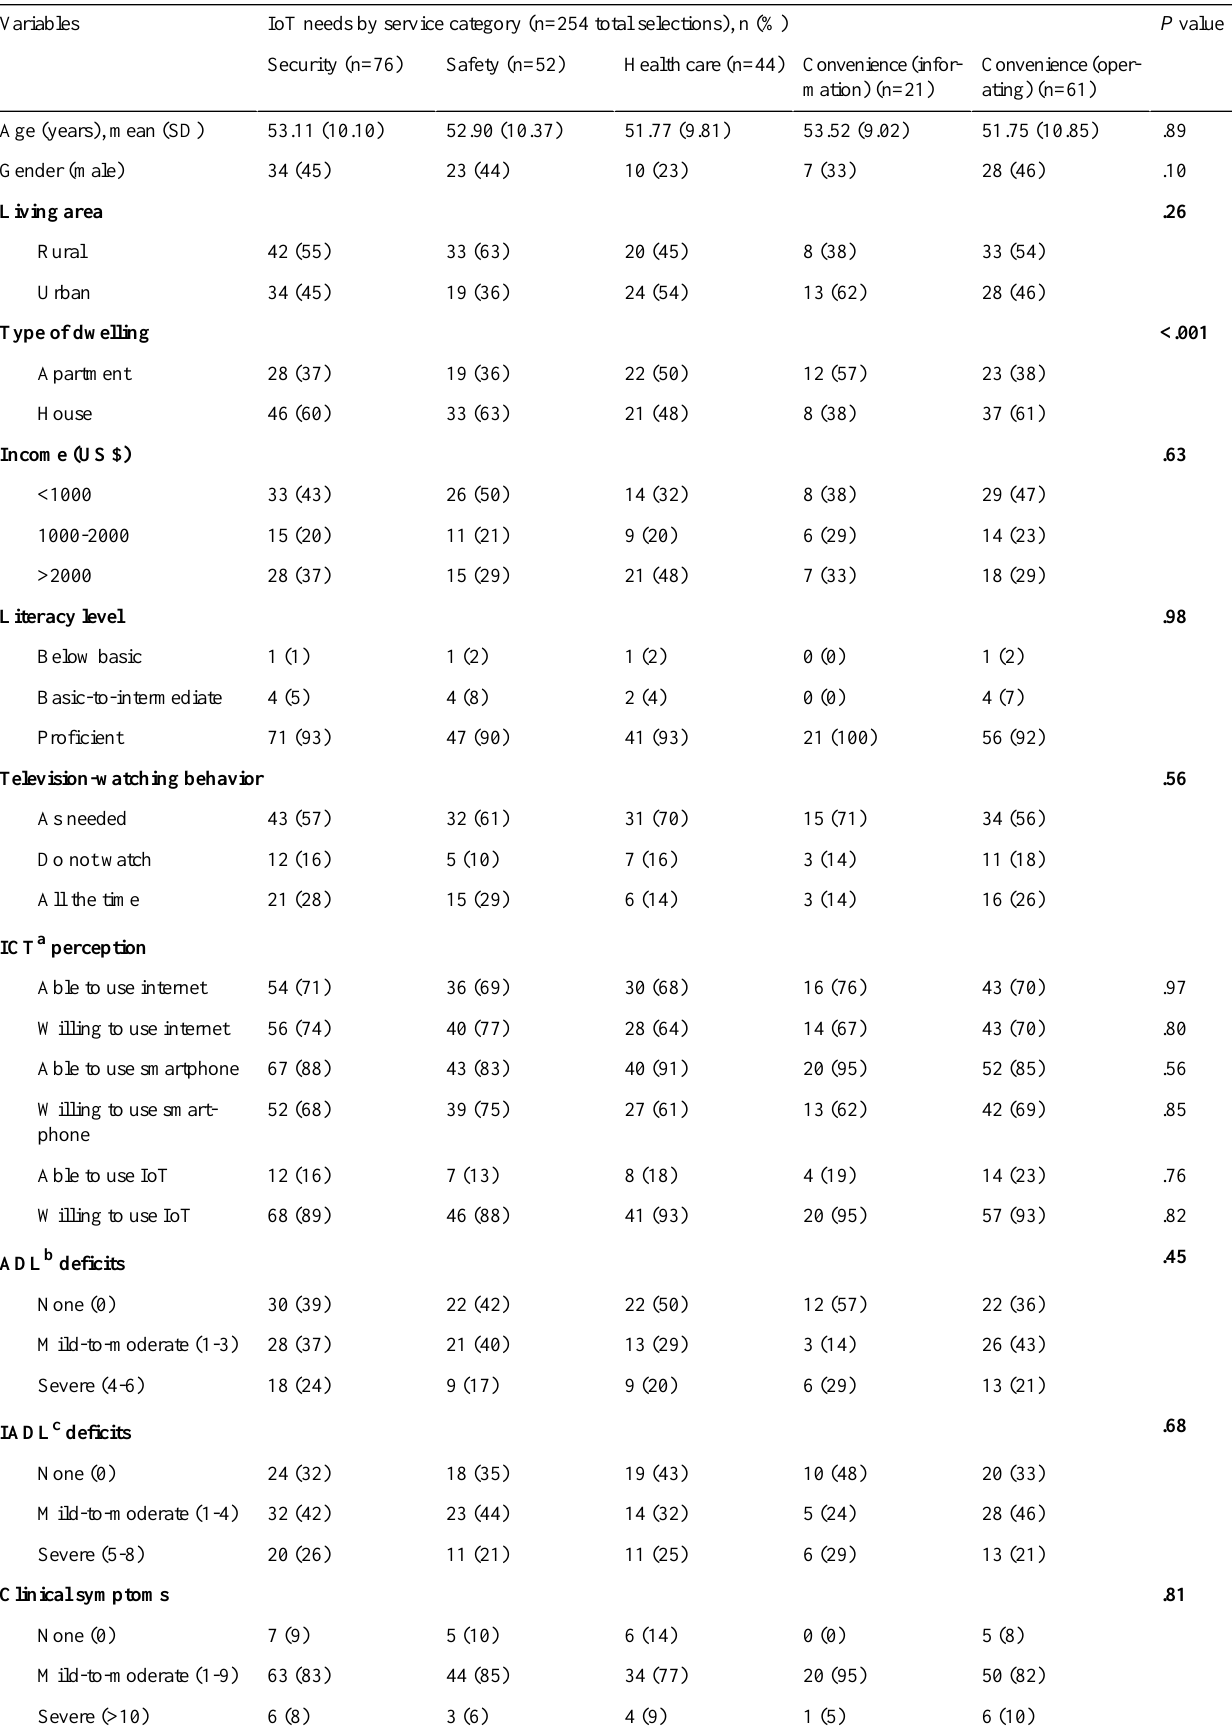
Table 5. Differences in underlying characteristics and conditions in terms of Internet of Things (IoT) category needs in disabled people.